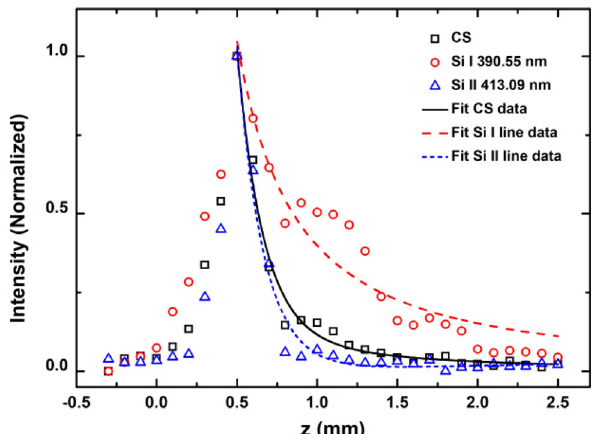
Figure 5. The spatial intensity distribution of CS, Si I line at 390.55 nm, and Si II line at 413.09 nm. The scatter dots are the experimental data, and the lines represent the EA